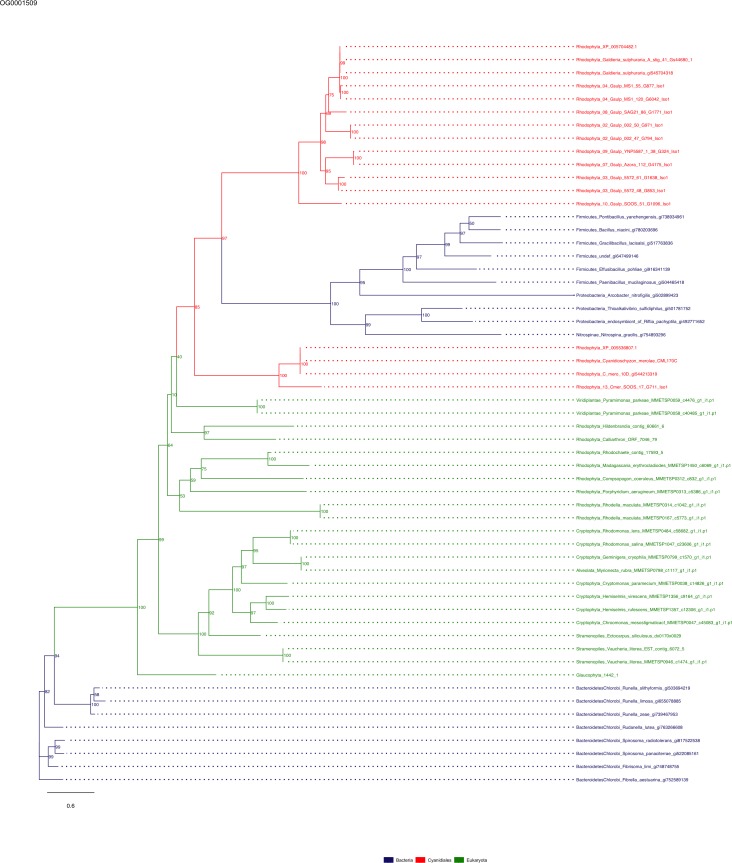
Sequence tree of orthogroup OG0001509.The tree is based on amino acid sequences. Archaea (yellow), Bacteria (blue), Cyanidiales (red), Eukaryotes including other red algae (green). Branches containing Cyanidiales sequences are highlited in red.